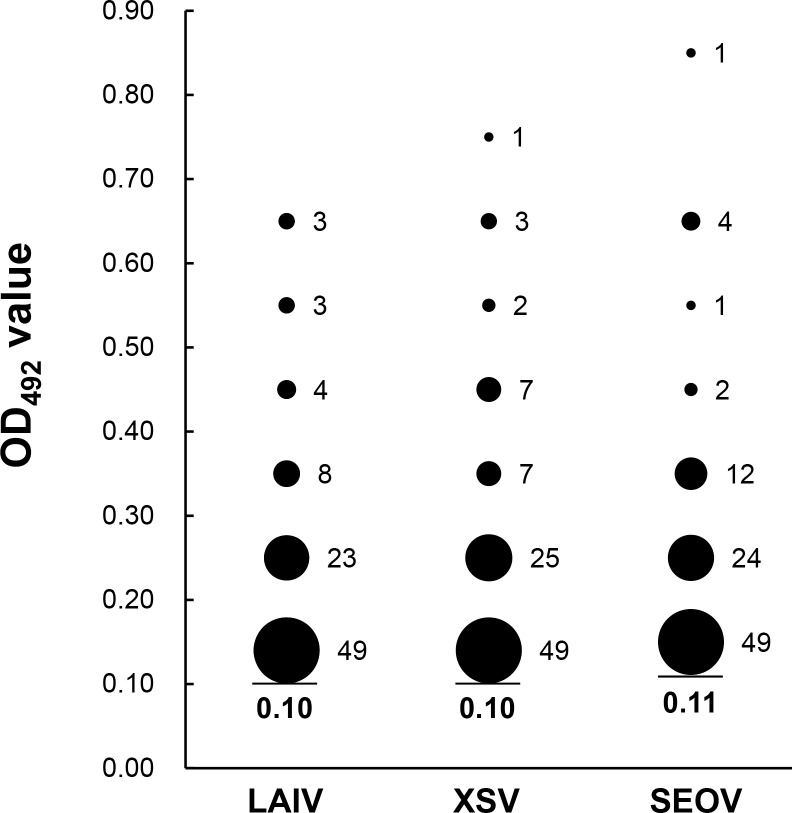
Distribution of OD492 values of positive bat sera (Y axis) against the rNP of each virus (X axis).